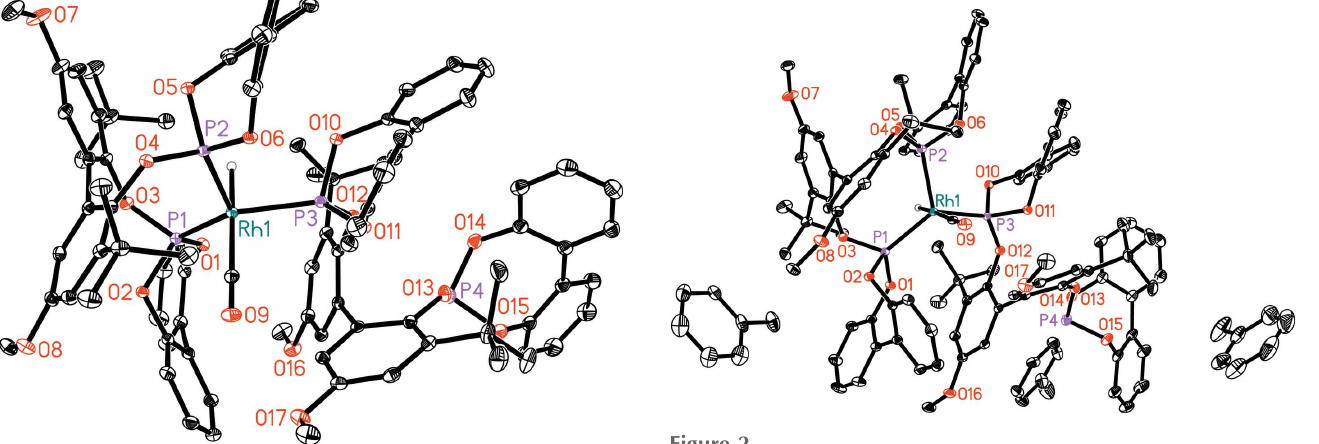
Figure 1 Molecular structure of the title compound with displacement ellipsoids drawn at 30% probability level. Co-crystallized solvent and C–bound hydrogen atoms are omitted for clarity.